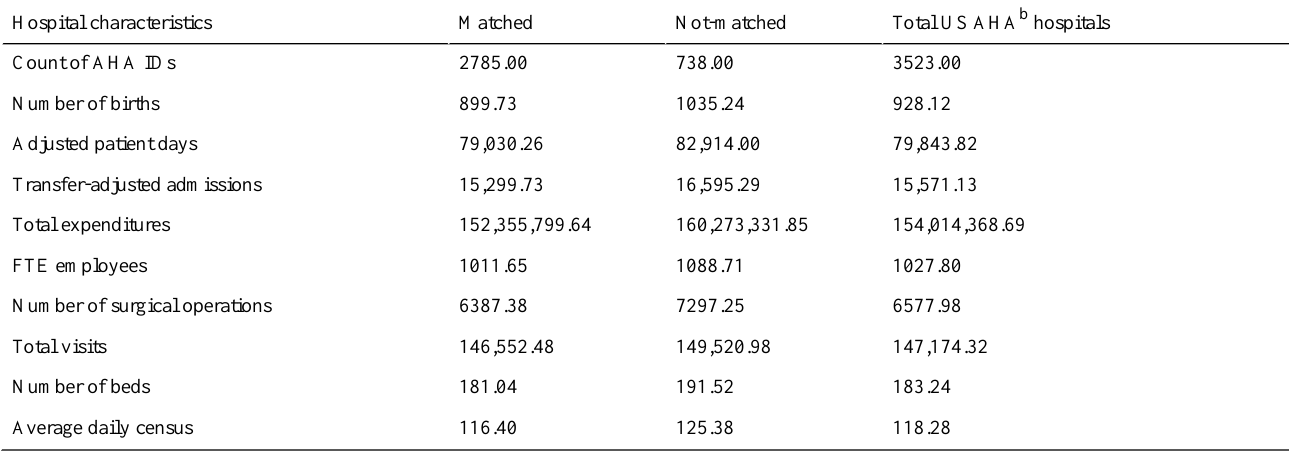
Table 1. Hospital characteristics for all US AHA a hospitals by inclusion in the study. b